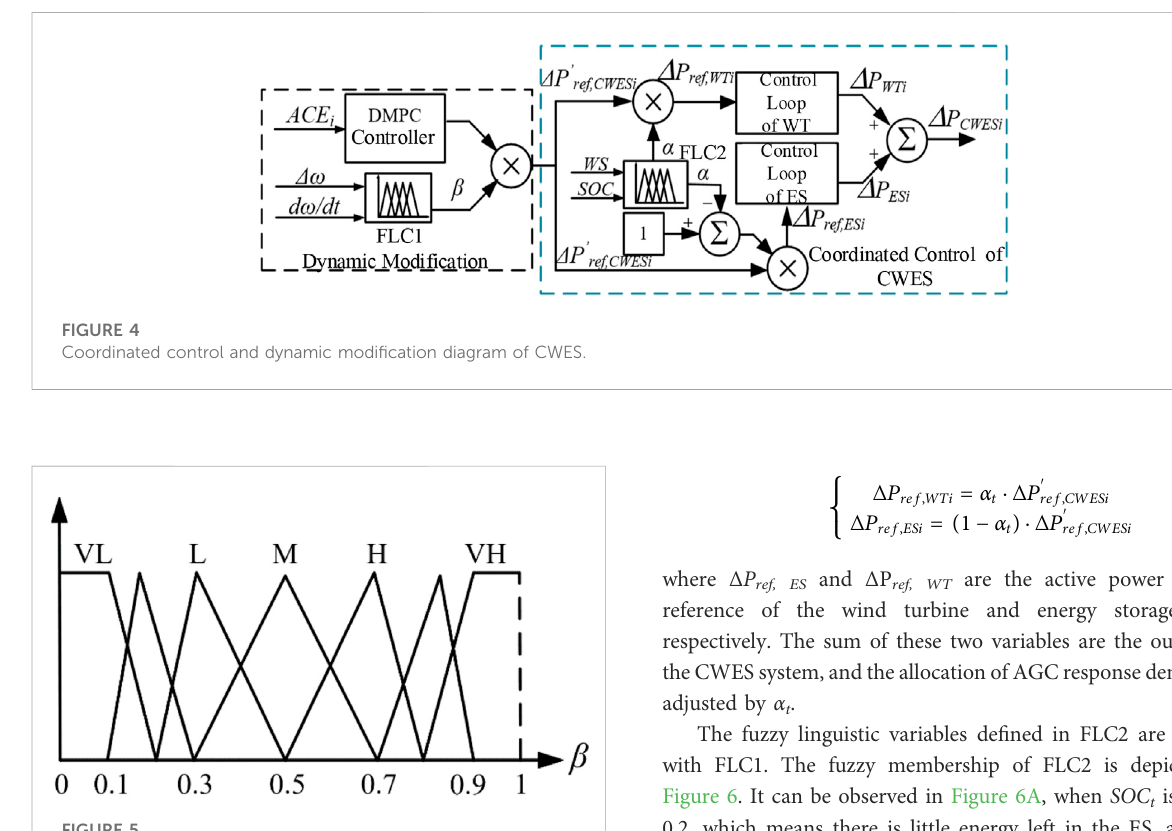
FIGURE 5 Fuzzy membership of FLC1 output.